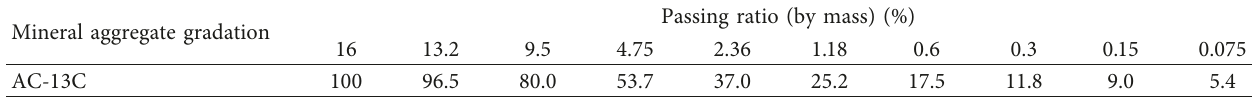
Table 3: Aggregate gradation used for AC-13C mixture.